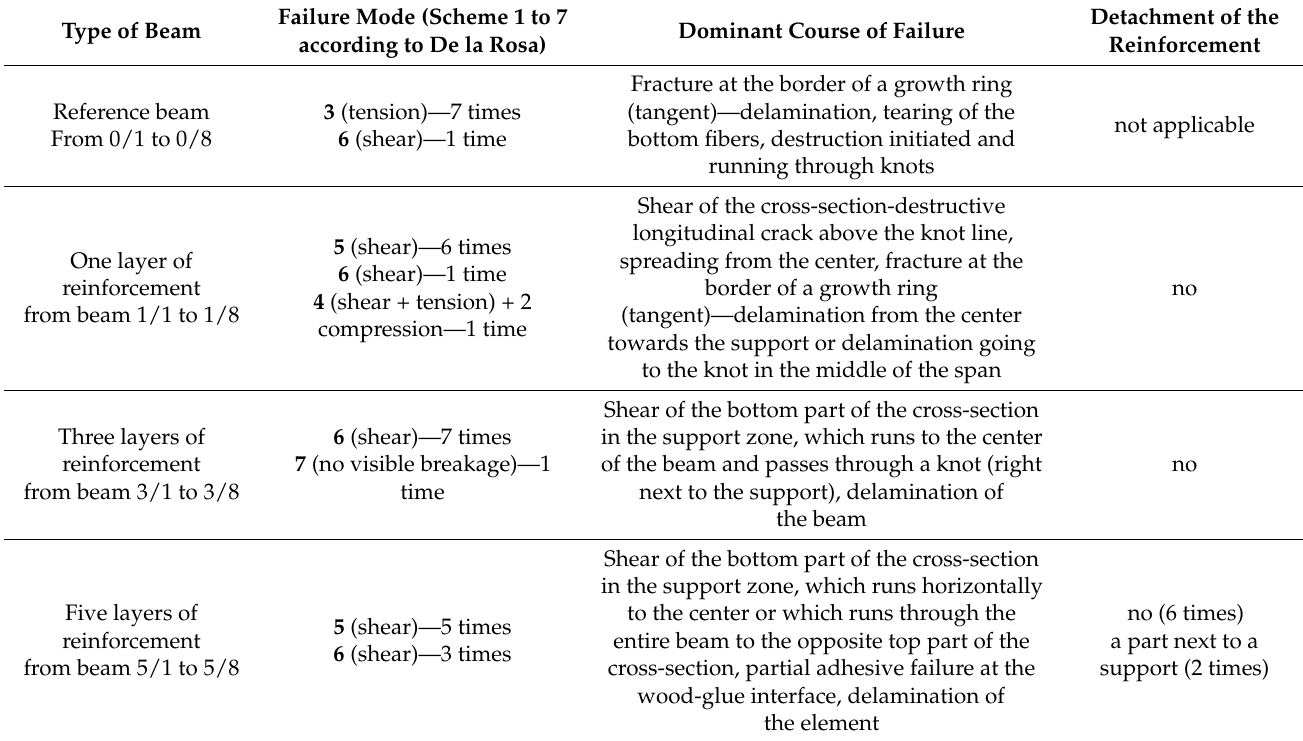
Table 4. Failure mode of the tested